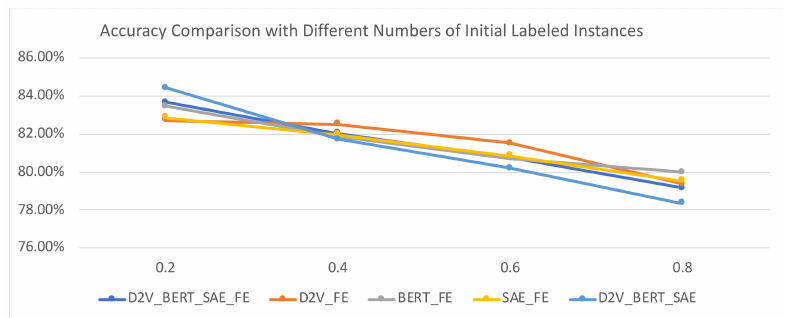
Figure 7. Accuracy comparison with different numbers of initial labeled instances.